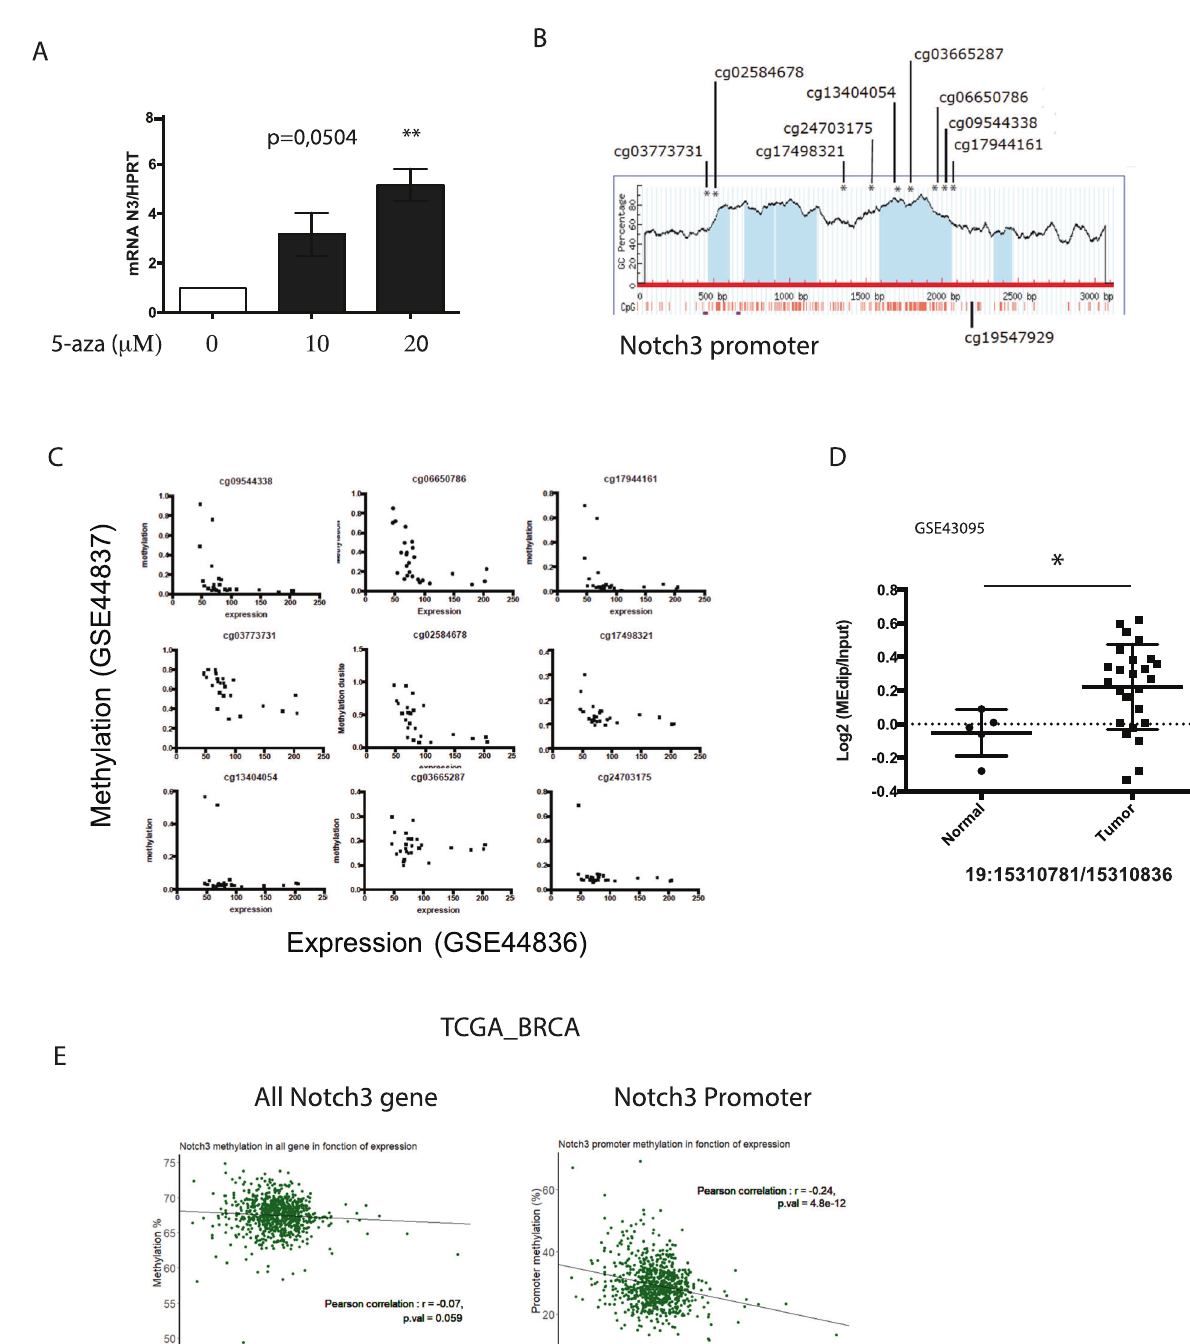
Fig. 2 Notch3 promoter methylation regulates Notch3 expression in breast cancer. A mRNA Notch3 expression in MDA-MB231 cells treated with 0 (control), 10 or 20 μ M 5-aza for 24 h assessed by RT-qPCR. B Notch3 promoter CpG island map with probes from the 450 K chip. C Correlation between methylation and expression of Notch3 for 9 CpG probes in 26 breast cancer cell lines (GSE44836 and GSE44837 datasets). D Methylation of Notch3 promoter region in 5 normal breast samples and 20 breast cancer samples (GSE43095 dataset). Student t - test was used. E Correlation between the mean of CpG methylation in all Notch3 gene (left) and in fi rst CpG island situated in the promoter of Notch3 (right) and Notch3 expression (TCGA data). Quantitative RT-PCR further validated the increase in E2F1 and Mybl2 of CDKN1A and CDKN2A in Notch3 null tumors (Supplementary target genes in Notch3-de fi cient tumors (Fig. 4C). To further Fig. S4F). GSEA also highlighted an enrichment in cell cycle regulators determine whether Notch3 expression could directly affect Mybl2 E2F1, G2M checkpoints and Mybl2 signature in Notch3 null tumors and the expression of its target genes, we investigated the effect of (Fig. 4A). Immunohistochemical staining of these tumors then Notch3 expression in MDA-MB-231 cells engineered to express revealed an upregulation of Mybl2 expression and enhanced Notch3 upon doxycycline expression (Fig. 3A). Induction of Notch3 in proliferation (MKI67 staining) (Fig. 4B and Supplementary Fig. S5). Cell Death and Disease (2023)